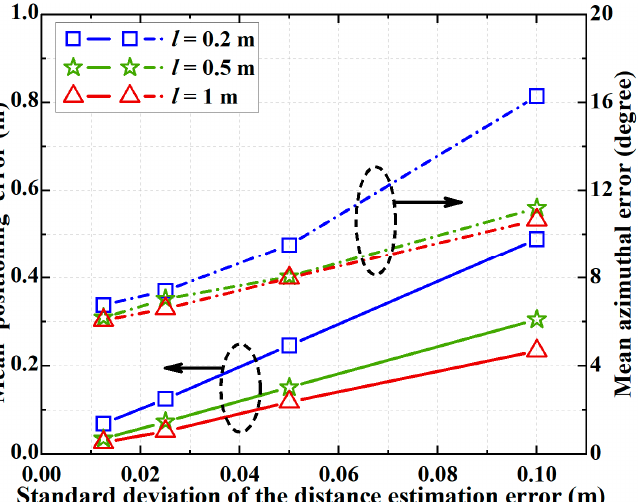
Figure 7. Mean positioning errors and azimuthal errors at the height of 1 m. ( θ = 0°).